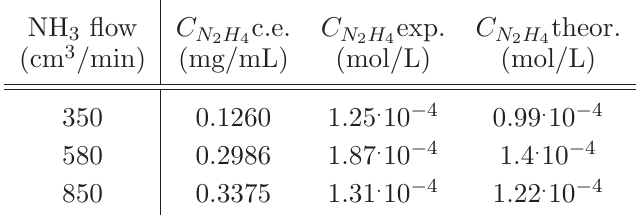
Table 3 lists the values of experimental and theoretical N 2 H 4 concentrations.